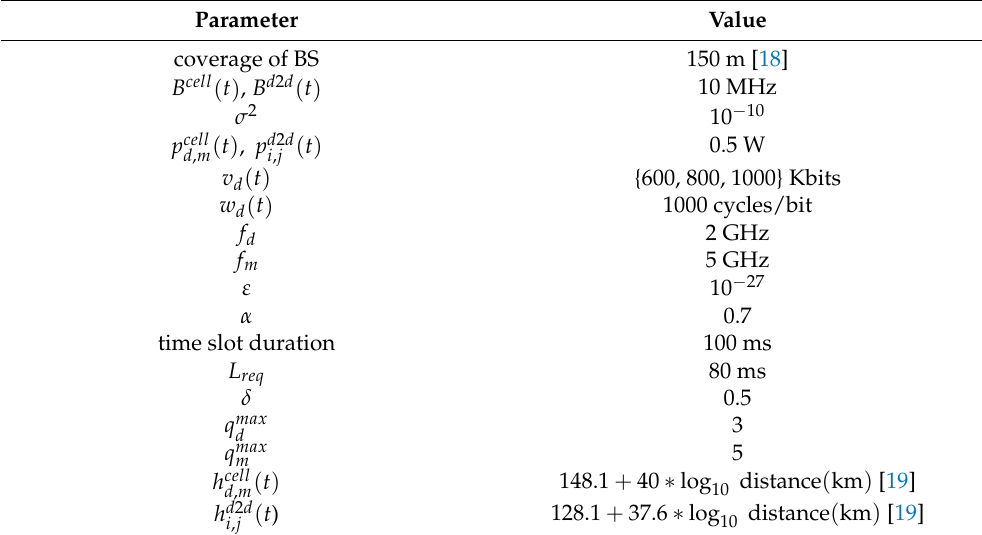
Table 1. Simulation